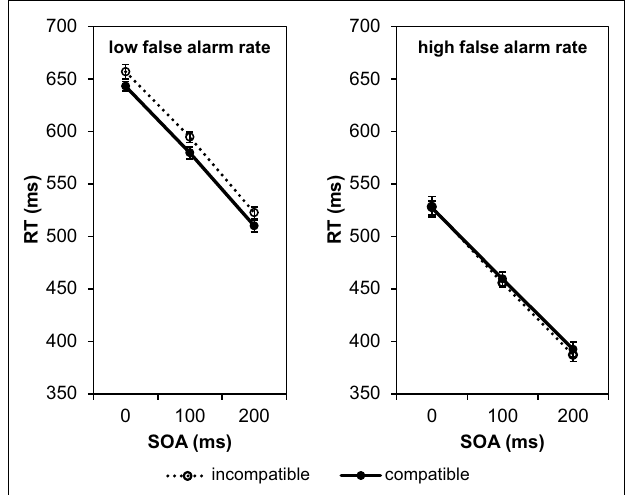
FIGURE 3 | Mean reaction times depending on SOA and compatibility conditions in Experiment 1. The left graph shows the result for participants with a low rate of false alarms (less than 20% responses in No-Go trials), the right graph for participants with a high rate of false alarms (more than 20% responses in No-Go